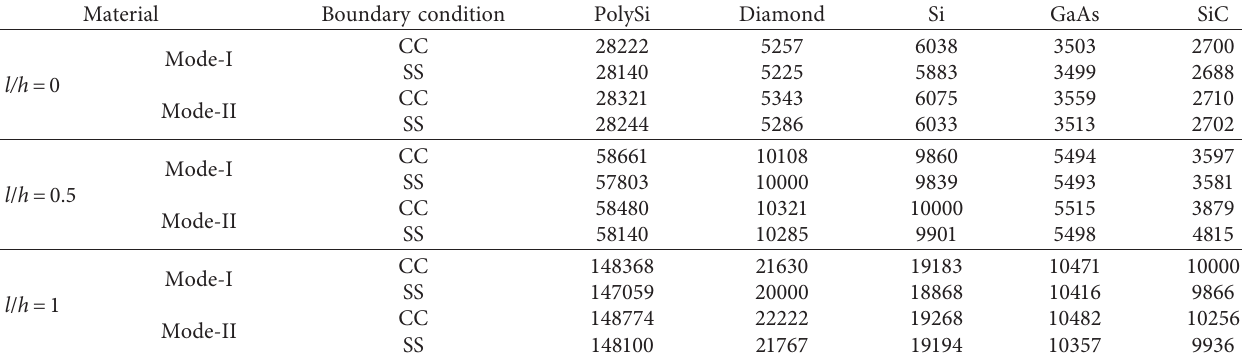
Table 1: Thermoelastic damping limited quality factor, Q TED , of a microplate with different structural materials, dimensionless length scale parameters, vibrating modes, and boundary types.